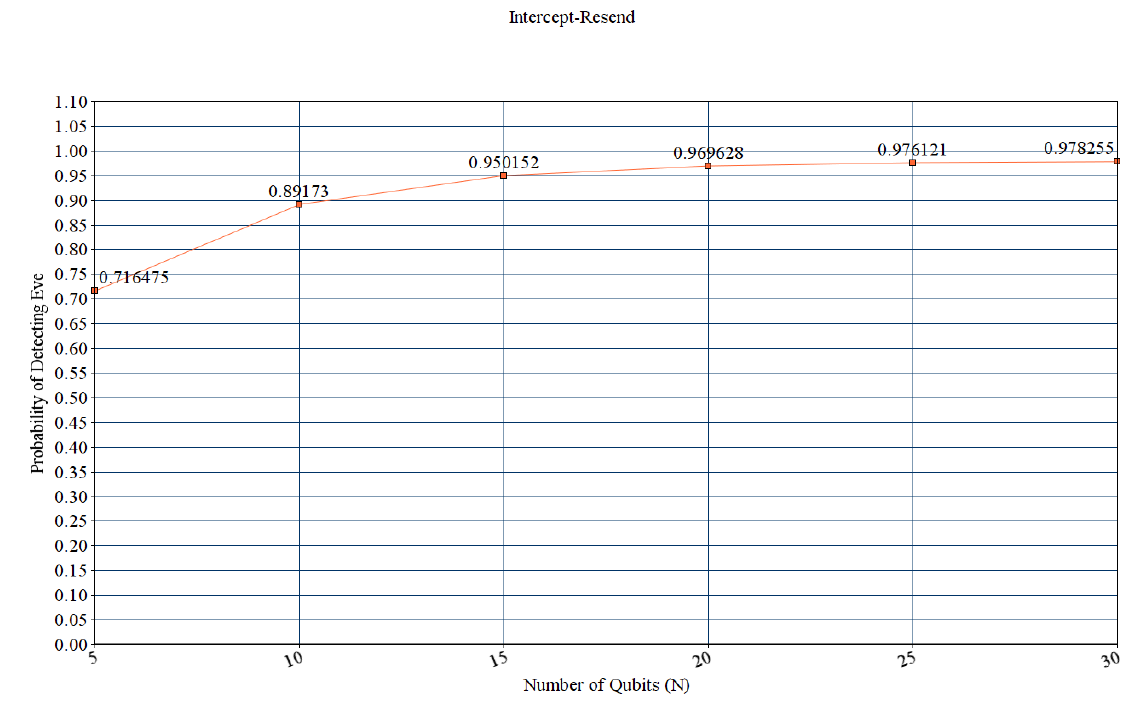
Figure 7. Probability of detecting Eve during Intercept Resend